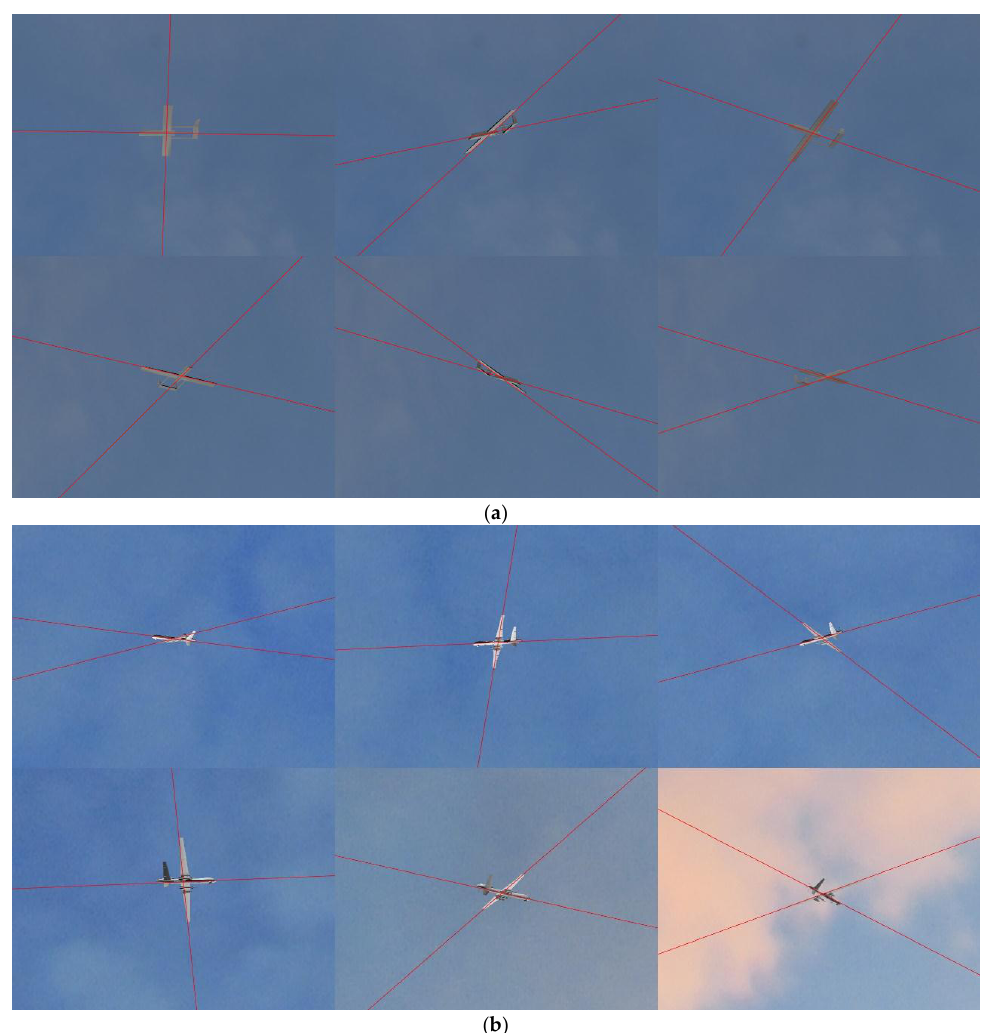
Figure 12. Structure extraction results on the simulated images: ( a ) Results on Model 1’s simulated image pairs; ( b ) Results on Model 2’s simulated image pairs.